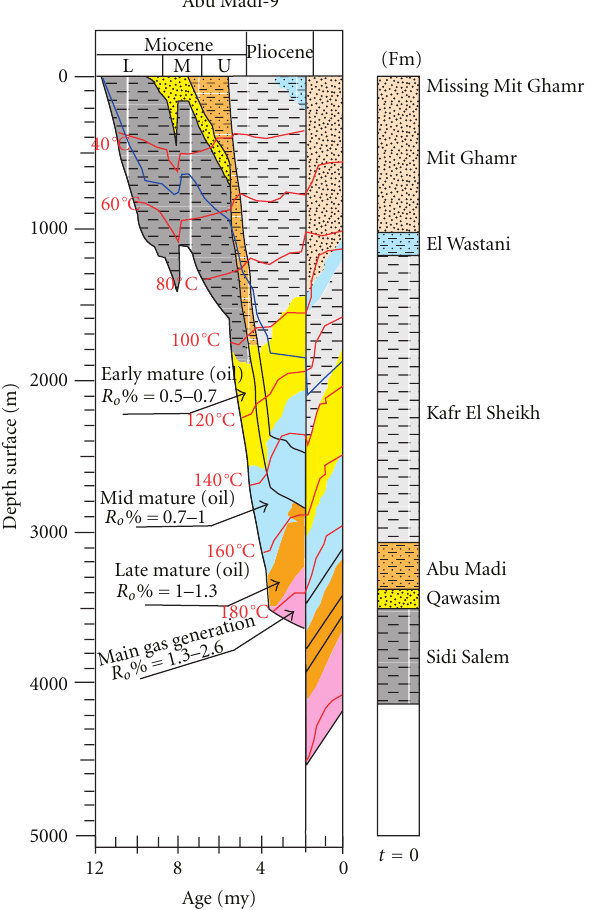
Figure 7: Burial history curve for Abu Madi-9 well showing kinetic window of stratigraphic units.